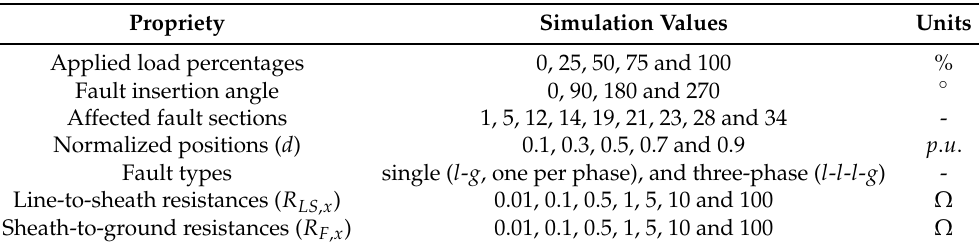
Table 2. Fault parameters for the simulation